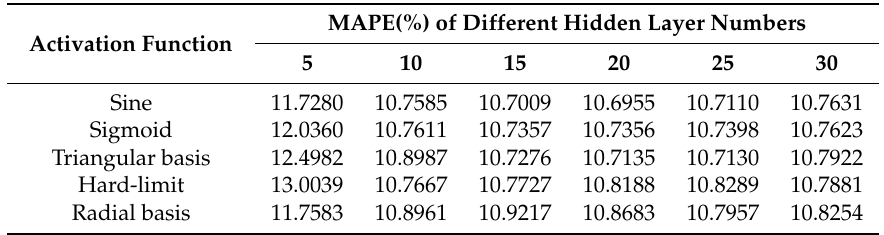
Table 4. Forecasting accuracy with different characters of WRELM.